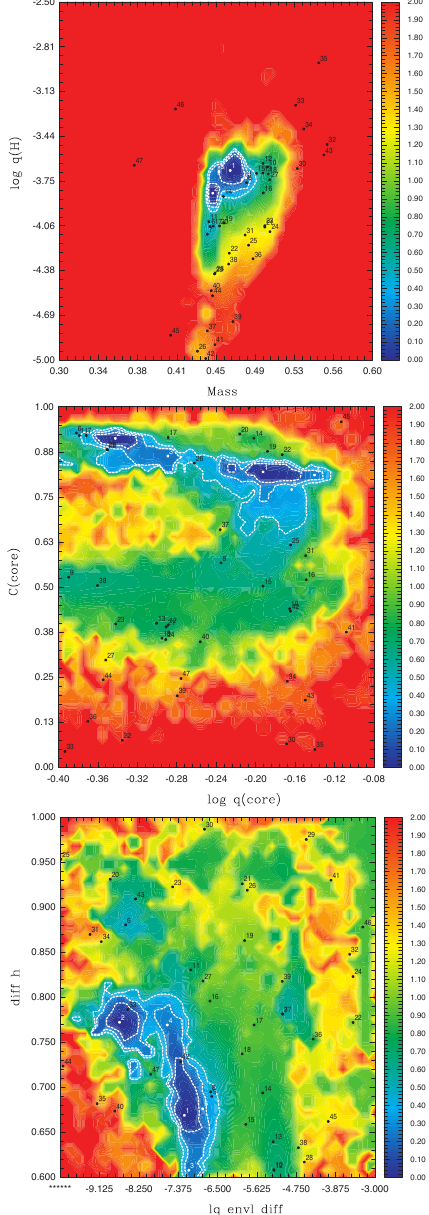
Figure 6. Optimization with 4G models. Top panel : map of the pro- jected merit function S 2 (on a logarithmic scale) in the log q (H)– M * plane. Middle panel : map of the projected merit function S 2 (on a logarithmic scale) in the log q ( core )– X ( C + O ) plane. Bottom panel : map of the projected merit function S 2 (on a logarithmic scale) in the lqEnvDiff–DiffH plane. Best-fit models are identified by their rank (1 for the lowest merit function, etc. Do not pay attention to solutions with rank higher than 5: the optimization code explores the parameter space until the last iteration, and this simply cor- responds to models computed during this last iteration). White contours show regions where the period fits have S 2 values within the 1 σ , 2 σ and 3 σ confidence levels relative to the best-fit